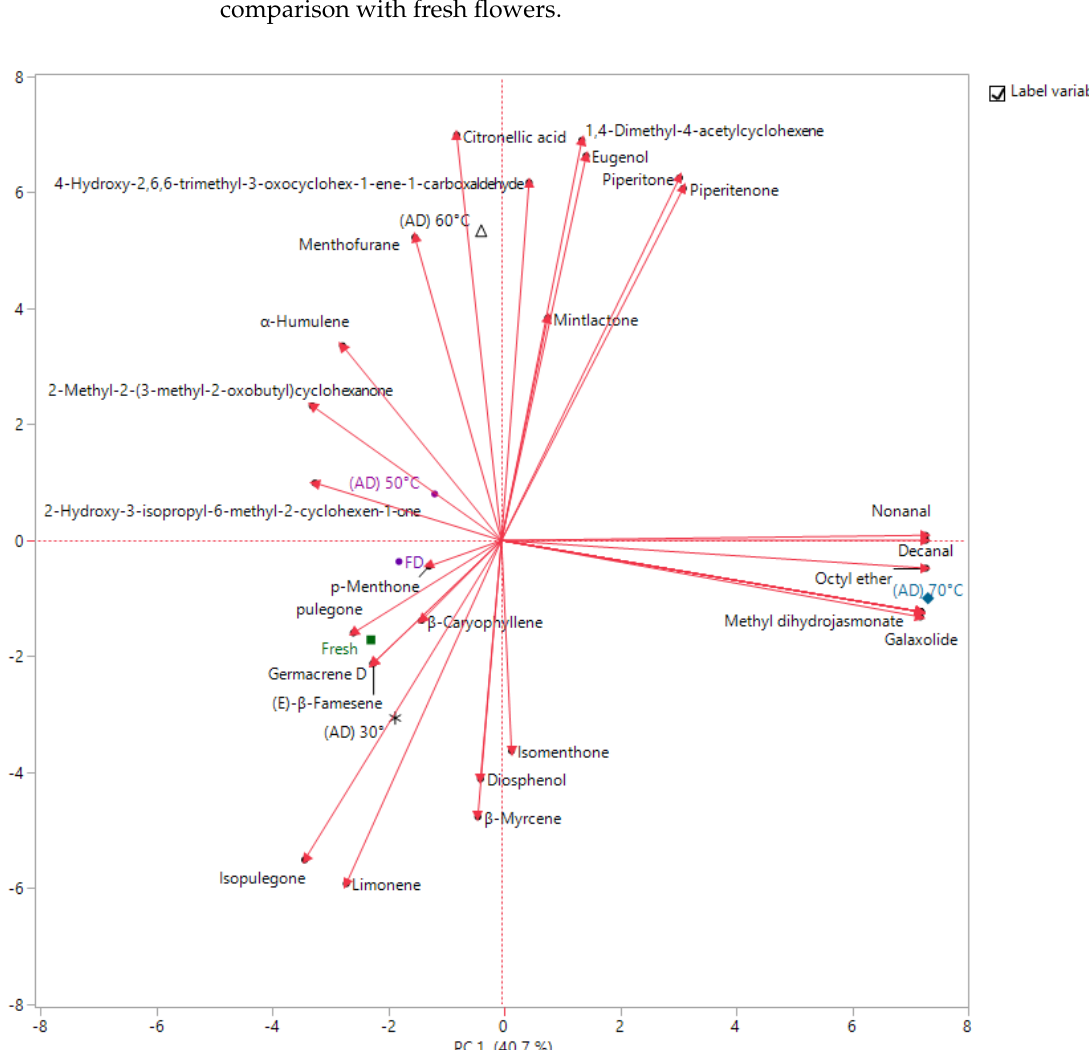
Figure 1. Scatter plot of the principal component analysis (PCA) of the volatile organic compounds (VOCs) of A. aurantiaca ‘Apricot Sprite’ flowers. Fresh Flowers, Freeze Drying (FD), ﹡ (AD) 30°C, (AD) 50 °C, (AD) 70 °C. PC1 (40.7%) axis was responsible for the segregation of the AD 70 °C flowers from the others due to its high amount in non-terpene compounds such as ester (methyl dihy- drojasmonate (12)) and ether (galaxoide (17)). In the left high quadrant (negative PC1, positive PC2), AD 60 °C sample was placed in the borderline, while AD 50 °C almost overlapped PC 2 axis. In the opposite quadrant (negative plot in both axes) were gathered fresh with FD and AD 30 °C flowers; this behavior was especially due to the amount of isopulegone and limonene. The two-way HCA analysis confirmed what was reported by PCA; in fact two main clusters were observed: C1, a homogeneous cluster formed by only AD 70 °C, and C2 englobed the rest of the samples. C2 is further divided into two subclusters: C2.a, homo- geneous and included only fresh flowers, and C2.b, which on its own can be divided into 2 subgroups: one formed by AD 30 °C and the other one with FD and AD 50 °C. (Figure 2).